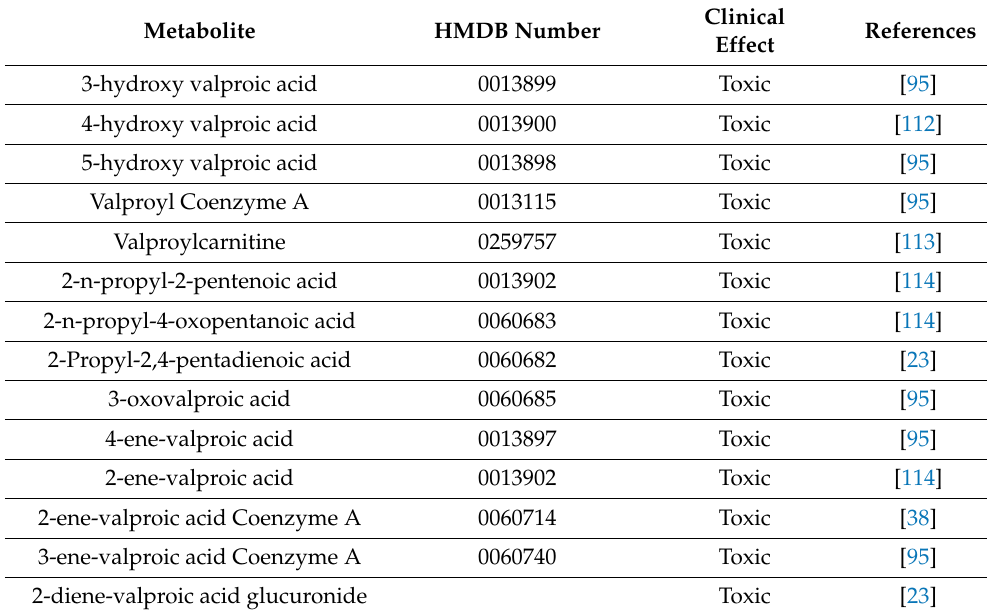
Table 3. Serum and Plasma Toxic Metabolites of Valproic Acid.